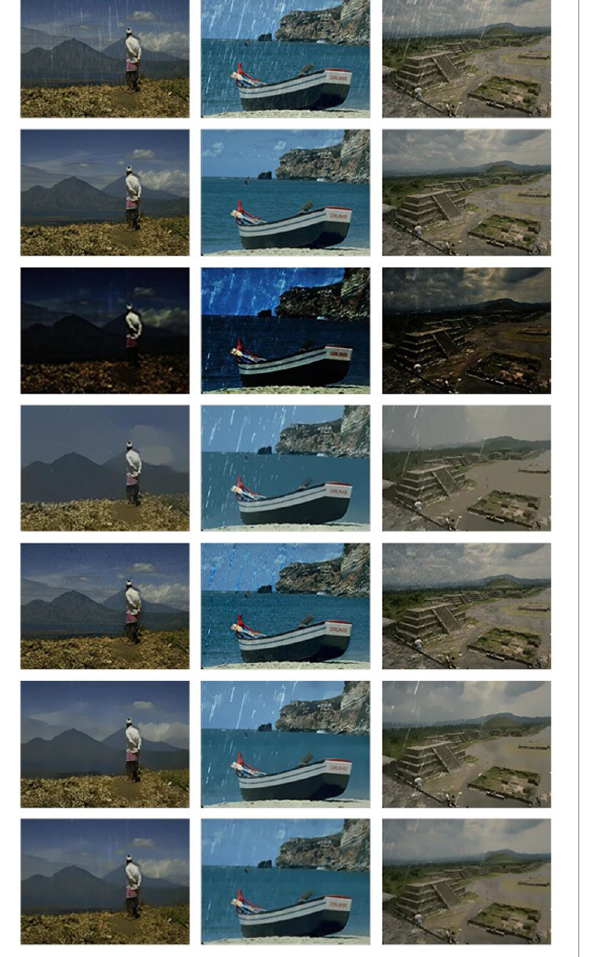
Fig. 3 Comparison of different rain removal methods on synthetic rainy images. The top row is the input rainy images, follows in sequence are the ground true, results with Li’s method [10], Manu’s method [6], Luo’s method [5], Huang’s method [3], and our method